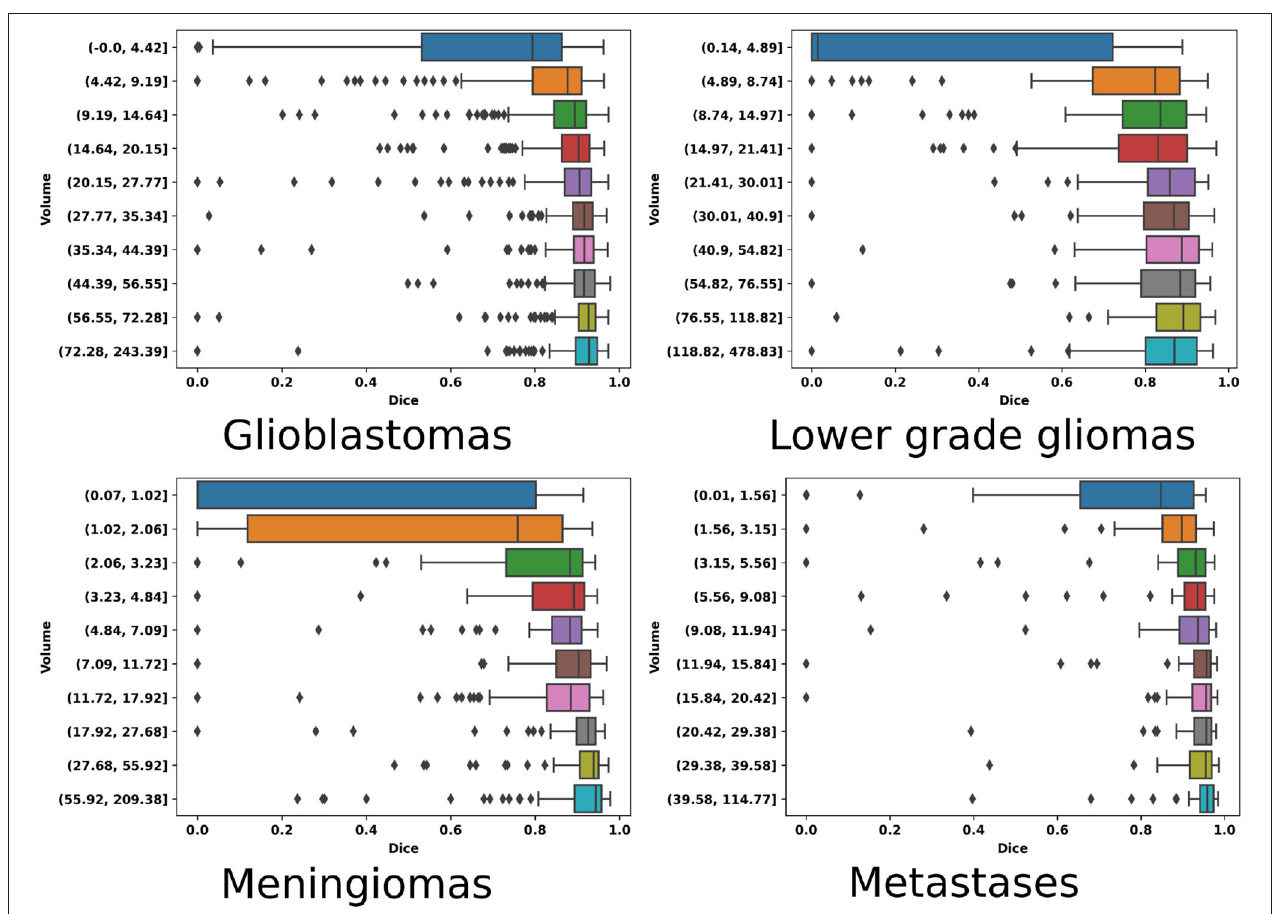
FIGURE 4 | Volume-wise (equally binned) Dice performance as boxplots for each of the four tumor